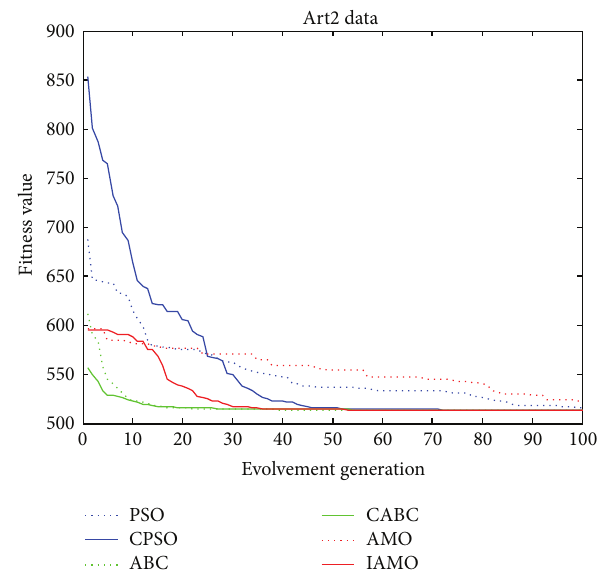
Figure 6: The convergence curve of the Art2